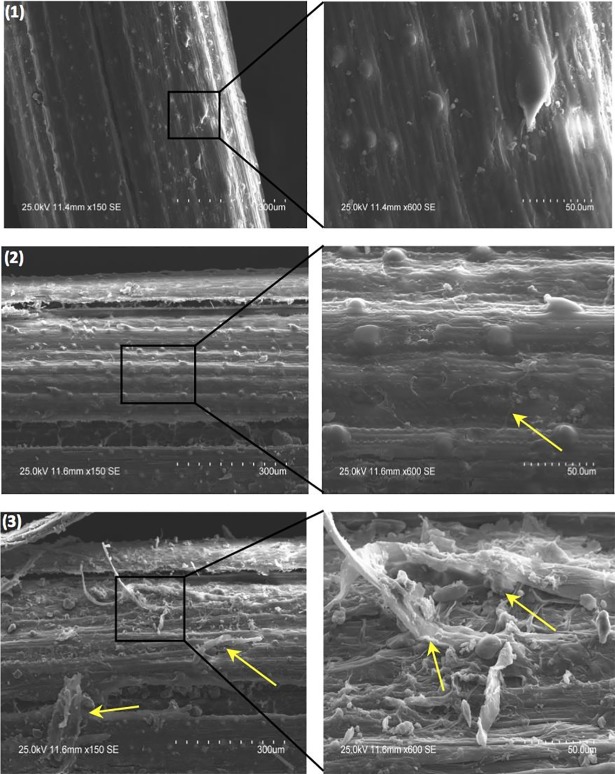
SEM images of F. altaica: (1) before decomposition, (2) after 317 days of decomposition without a covering of loess (‘not buried’), and (3) after 317 days of decomposition under a thin covering of loess (‘buried’). (Yellow arrows point to fungal hypha).